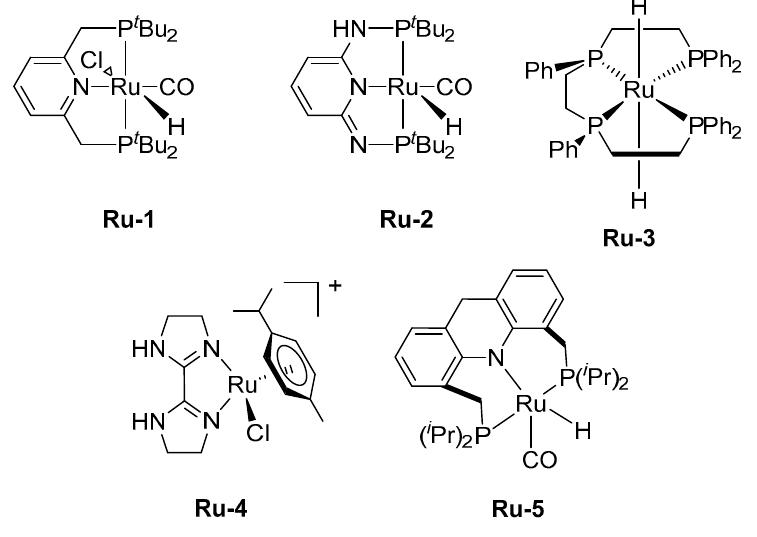
Figure 1. Ru catalysts for FADH.